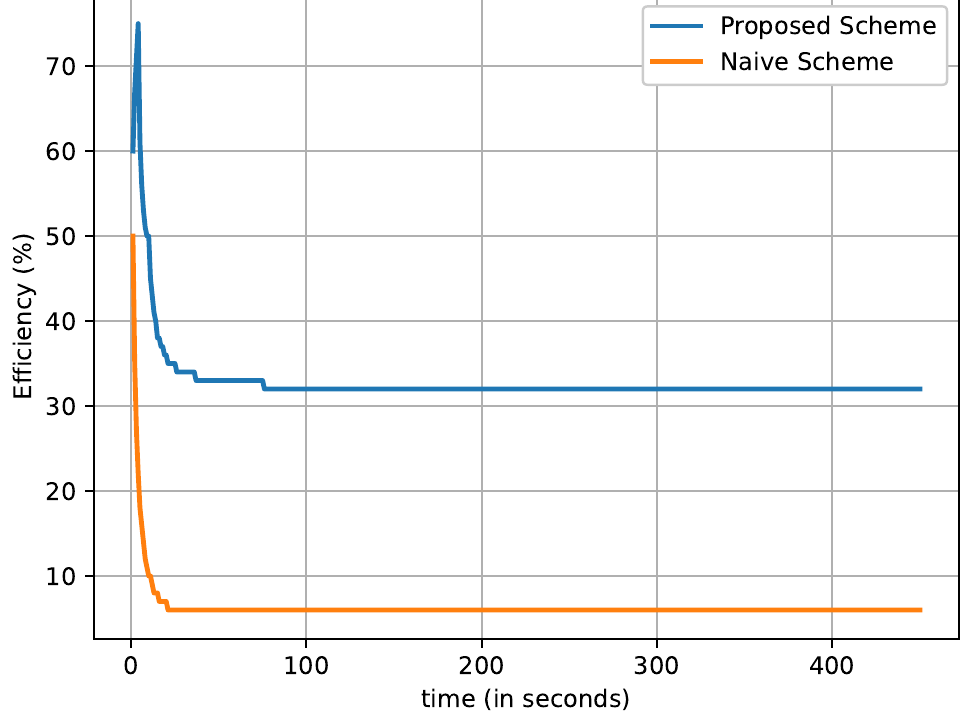
Figure 8. Efficiency in